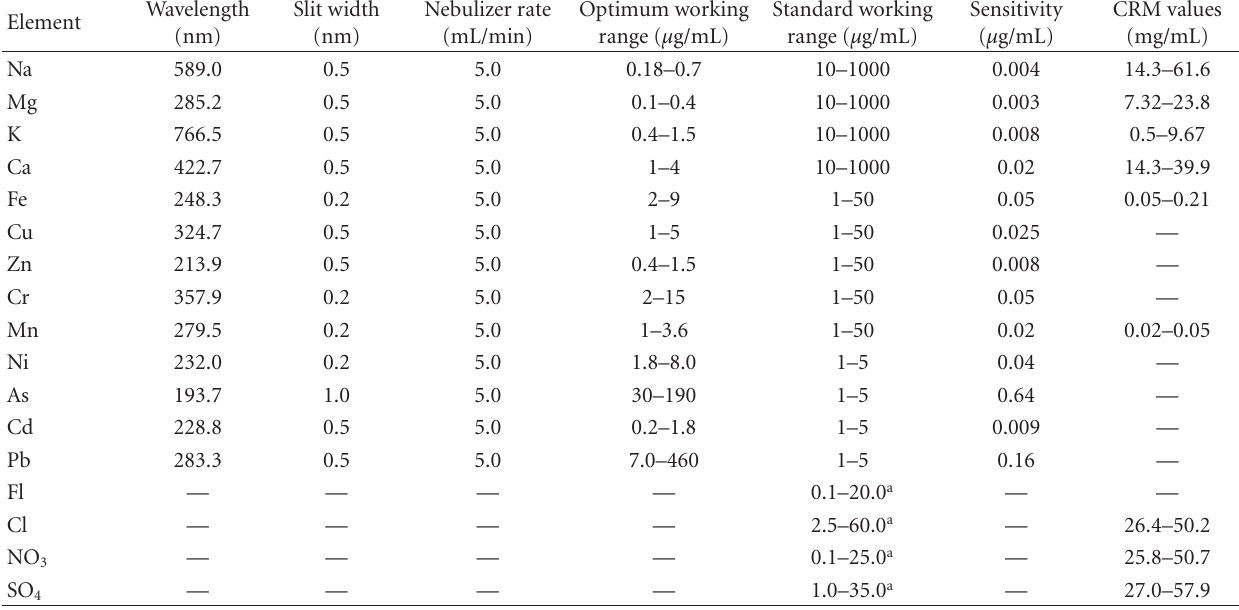
Table 1: AAS analytical conditions for determination of minerals in drinking water and mineral water samples.